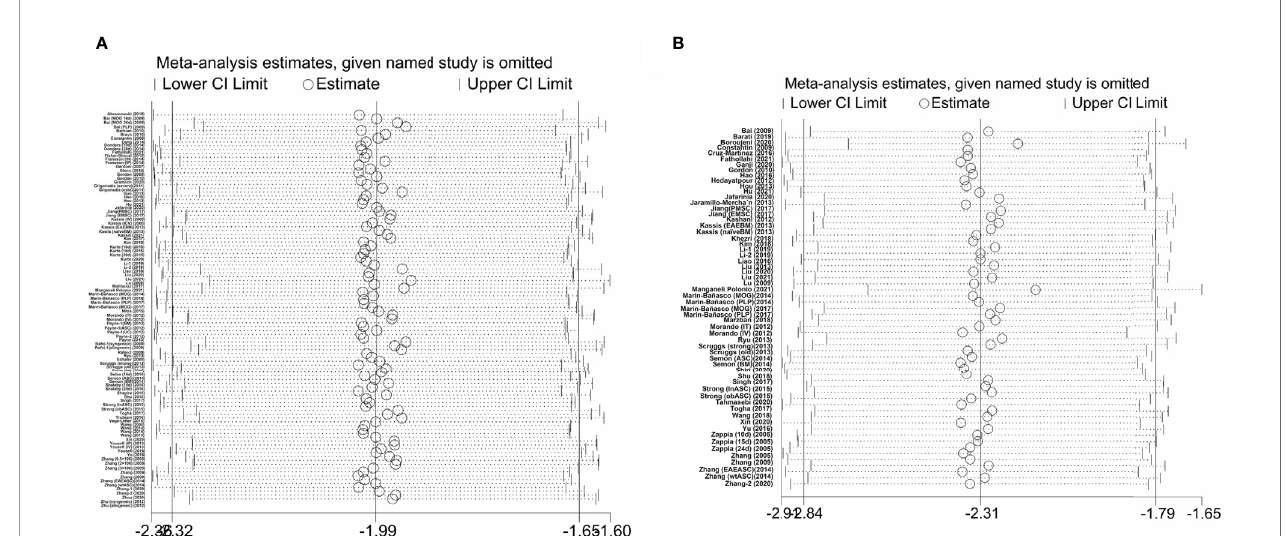
FIGURE 3 | Sensitivity analysis of the studies included in clinical score (A) and remyelination (B)